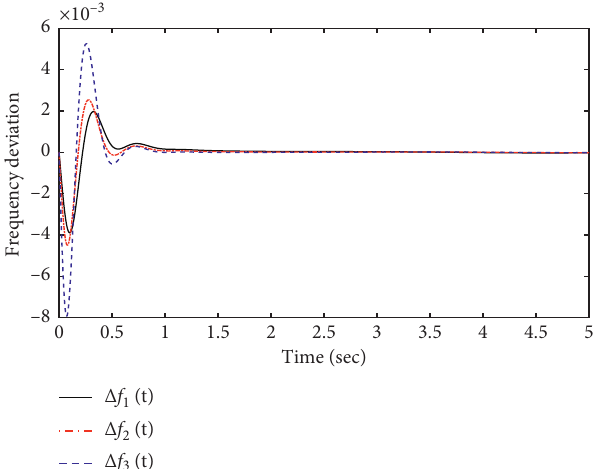
Figure 8: Frequency deviation of the system under mismatched uncertainty.